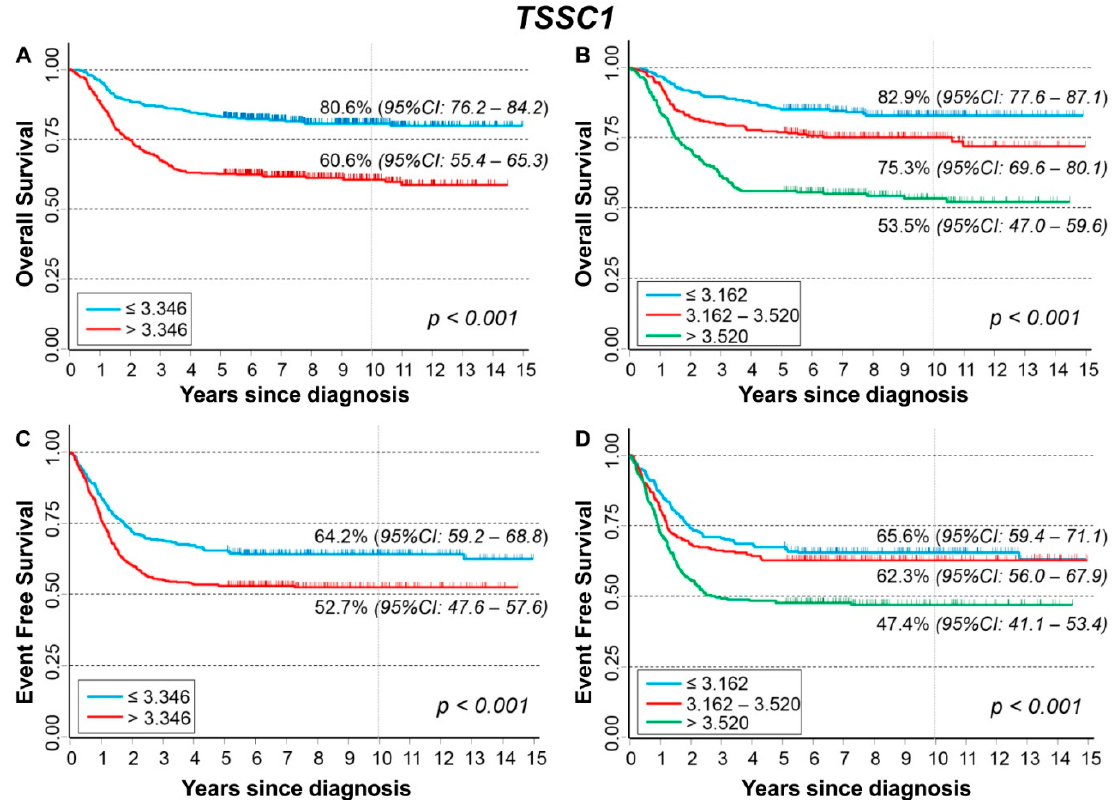
Figure 7. Patient Survival in relation to TSSC1 expression level. Overall Survival of 786 NB patients with ( A ) cut-off based on the median expression value or ( B ) on tertile expression values. Event Free Survival of 769 NB patients with ( C ) cut-off based on the median expression value or ( D ) on tertile expression values. Ten-year survival estimates are displayed. Table 6. Overall Survival of 786 NB patients in relation to TSSC1 expression levels evaluated by the Cox model.